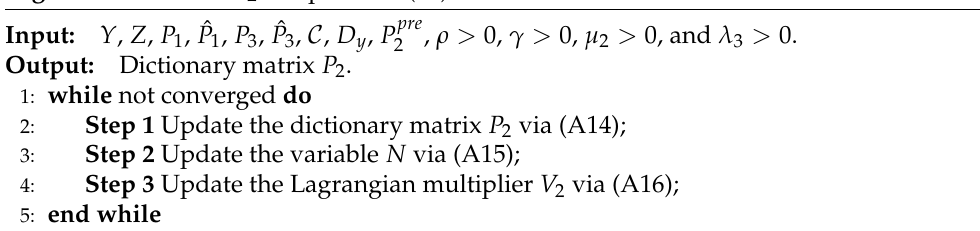
Algorithm A2 Solve P 2 -Subproblem (15) with